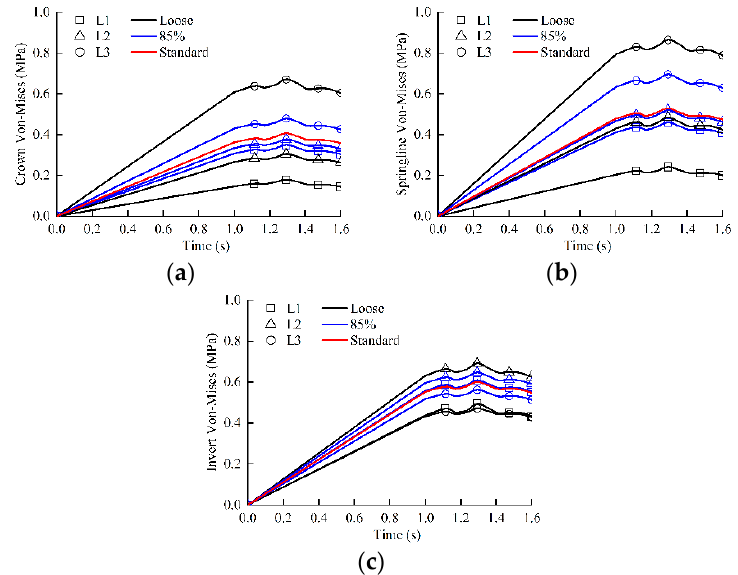
Figure 10. Time history curves of Von-Mises stresses under tra ffi c load: ( a ) the crown; ( b ) the springline; ( c ) the